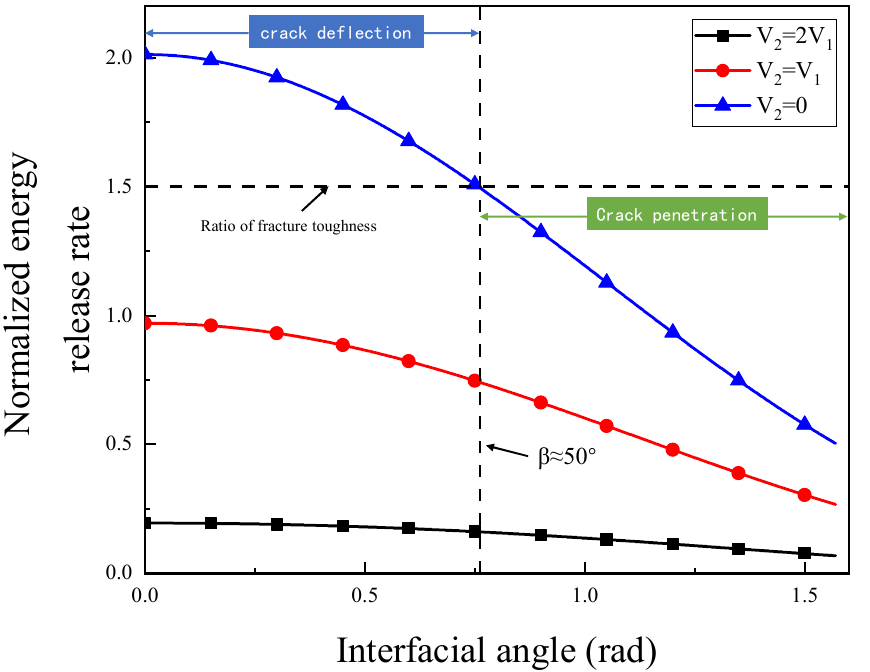
Figure 19. Schematic diagram of the normalized energy release rate interfacial angle curve.